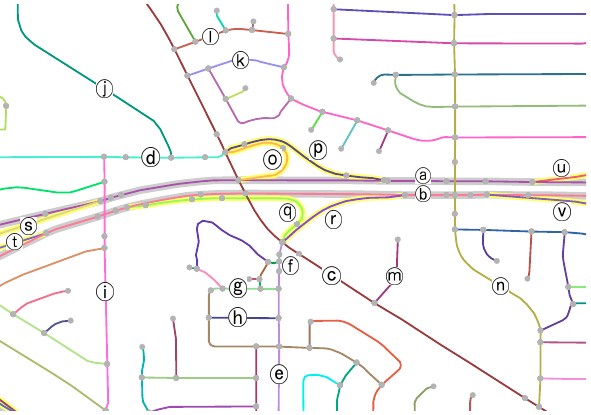
Figure 10. Road network N around complex junction No.9 clipped from the test data.